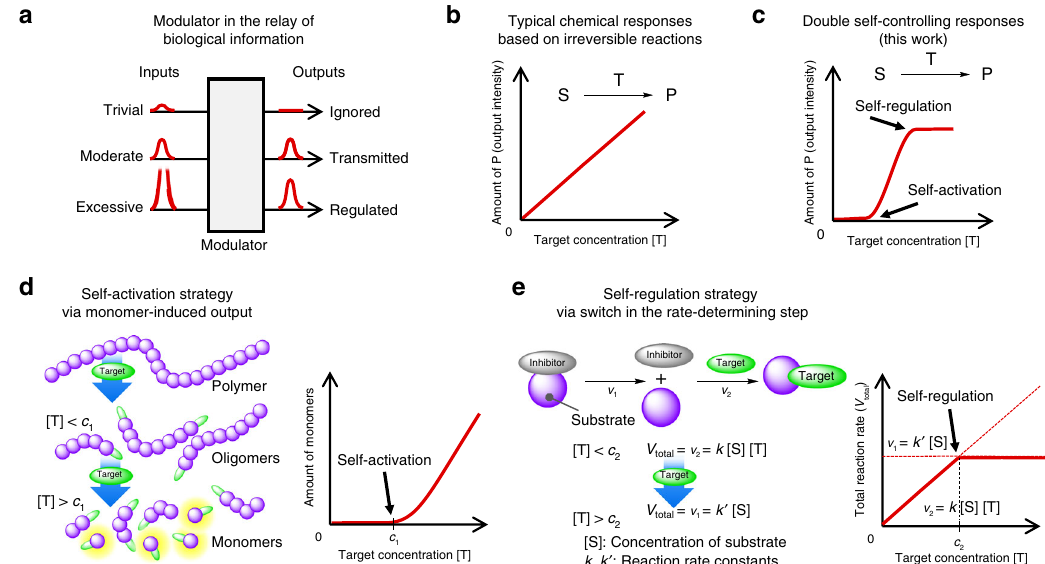
Fig. 1 Conceptual illustration of sigmoidal response by dual self-controlling system. a Modulator in the relay of biological information. b Chemical responses for the target concentration in conventional responses. c Dual self-controlling responses (this work) (S: substrate, T: target, and P: product). d Schematic strategies for self-activation based on random depolymerization. e Self-regulation based on a switch in the rate-determining step ( c 1 and c 2 are the threshold